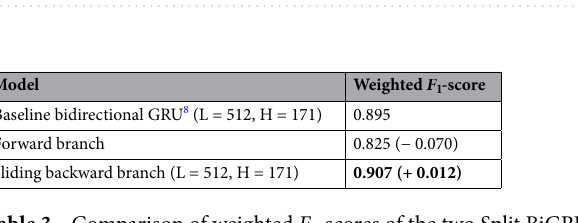
Table 3. Comparison of weighted F 1 -scores of the two Split BiGRU branches and a baseline BiGRU. The highest score value is indicated in